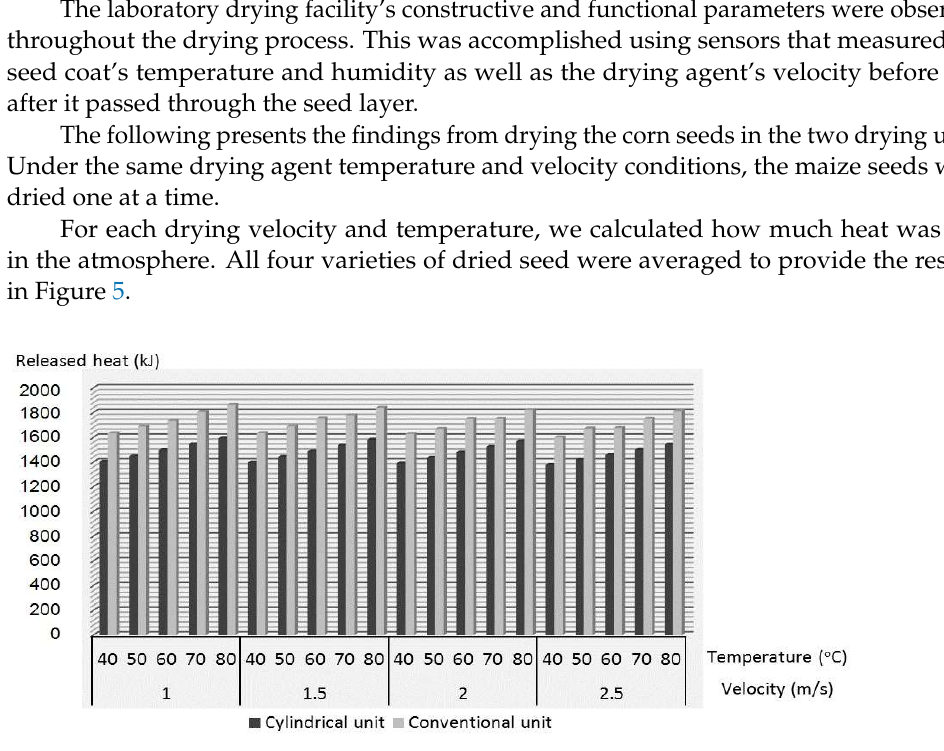
tion. For a temperature of 60 °C and a velocity of 2 m/s, a drop of up to 15.38% was